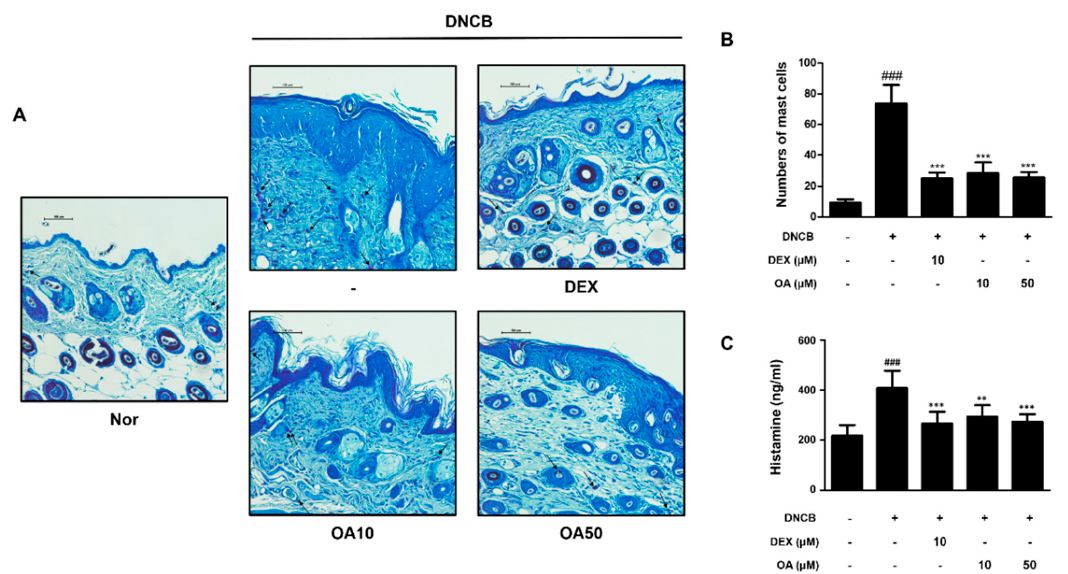
Figure 3. Effect of OA on mast cell infiltration and serum histamine level in DNCB-induced AD skin lesions. ( A ) Toluidine blue stained AD mouse skin lesions (scale bar = 100 µ m). Black arrows indicated stained mast cells. ( B ) Number of mast cells per mm section. Mast cell infiltration in toluidine blue stained sections is expressed as the average total count in five fields. ( C ) Histamine release in mouse serum was measured using an ELISA kit. The data shown represent mean ± S.D. ( n = 6) of three independent experiments. ### p < 0.001 vs. the control group; ** p < 0.01 and *** p < 0.001 vs. DNCB-treated group.